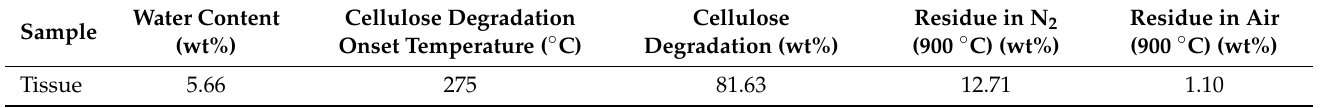
Table 2. Main components of cellulosic tissues elucidated by